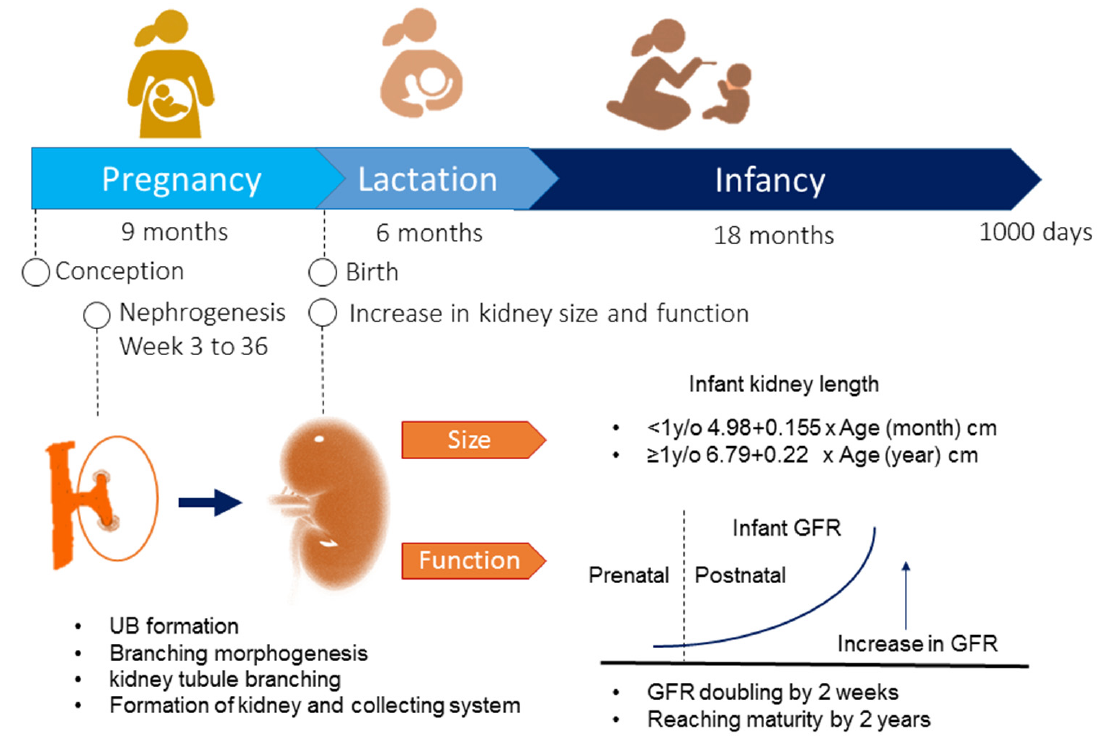
Figure 1. Kidney development during the first 1000 days of life. UB = ureteric bud; GFR = glomerular filtration